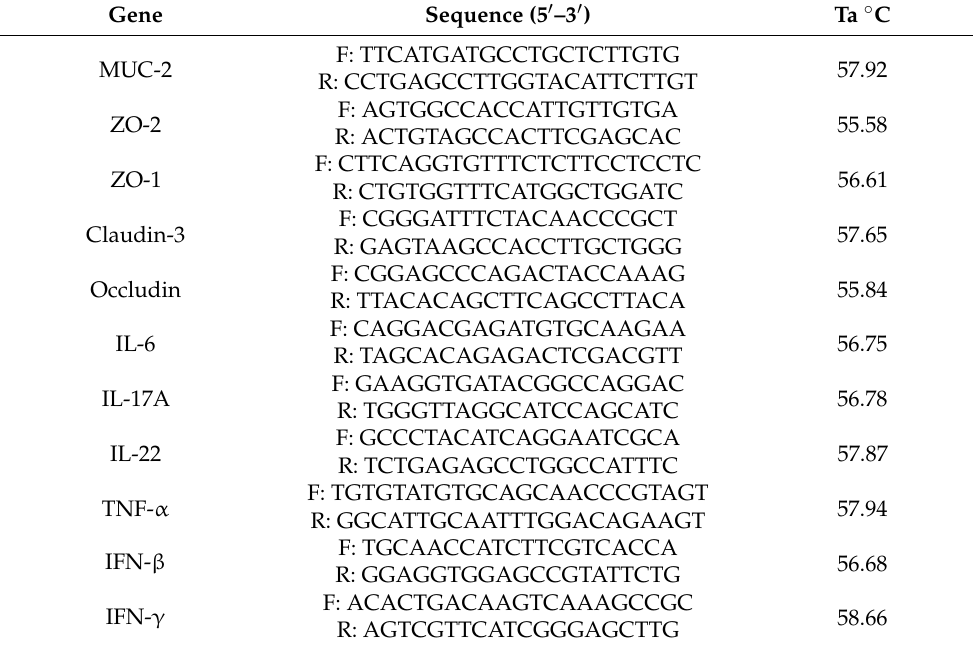
Table 2. The primer sequence of the